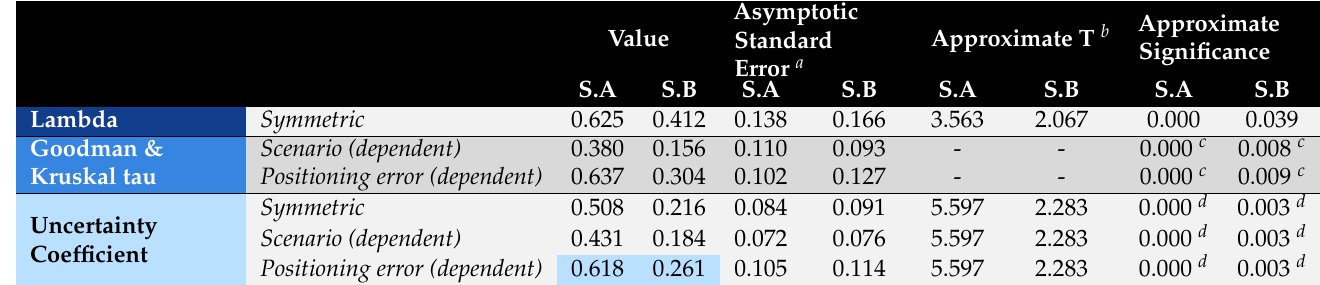
Table 2. Directional measures of association between two scenarios ( S.A and S.B ) and the reconstruction 3D errors. Uncertainty coefficients of 0.618 and 0.261 are estimated and considered to be statistically significant ( p < 0.01 for S.A and p < 0.05 for S.B